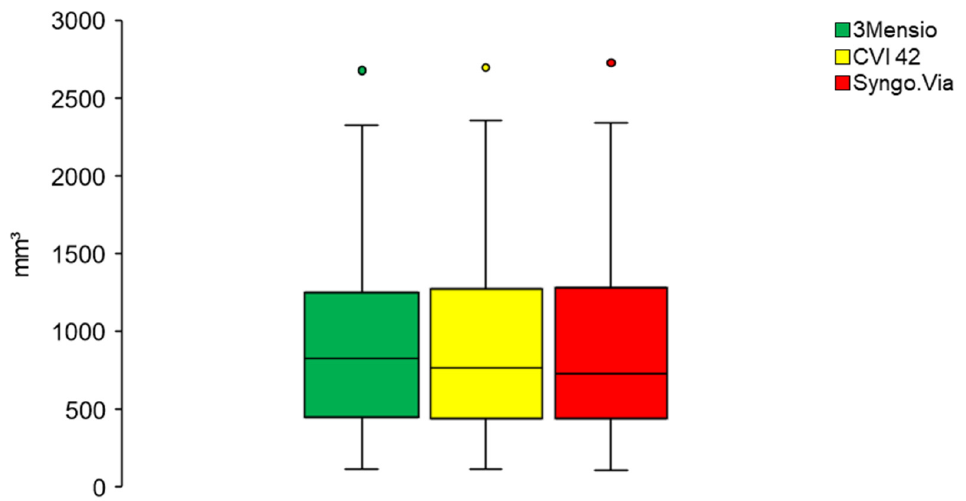
Figure 2. AVC calculation using three software solutions. A comparison of AVC measured in a cohort of 50 patients, using three different software types. There was no significant difference in AVC (Friedmann test for continuous data with deviations from normality; p = 0.455). AVC: aortic valve calcification.